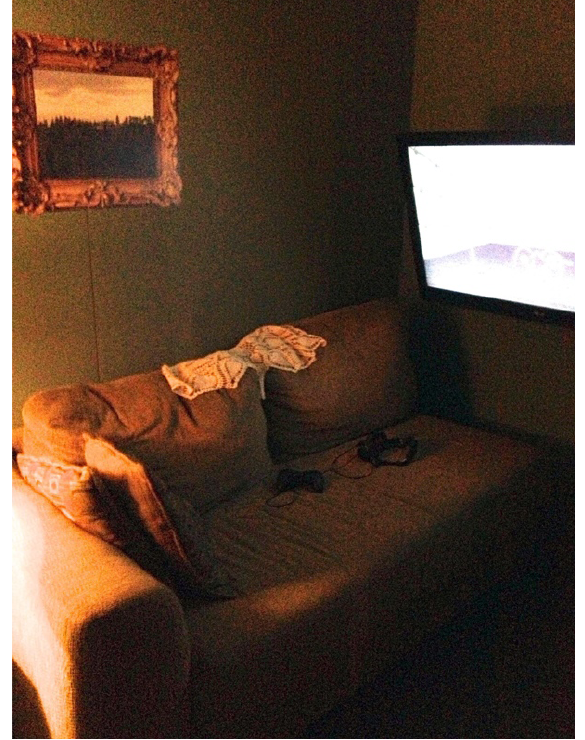
Figure 5. Installation photo from Psychasthenia 2 web- site. Courtesy of the authors.